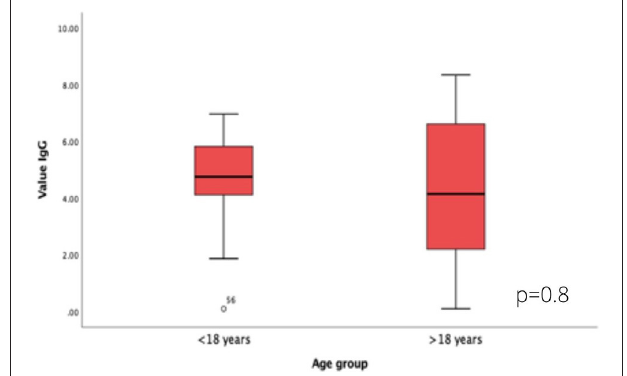
FIGURE 3 | Differences in SARS-CoV-2 IgG values according to age